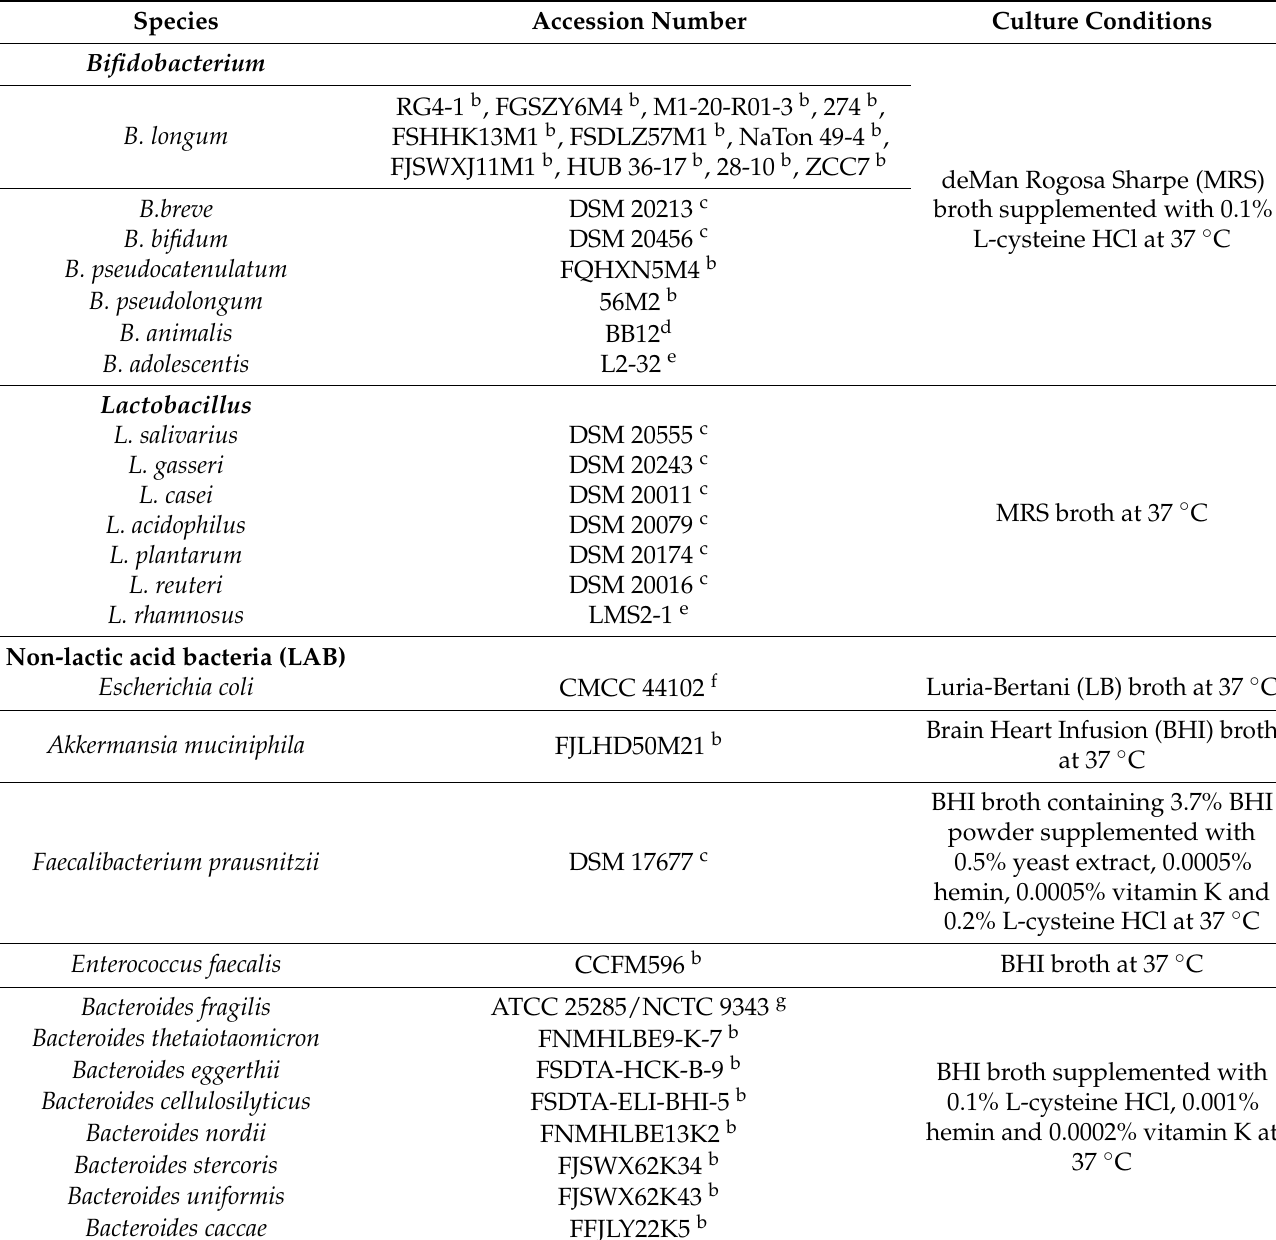
Table 1. Bacterial strains used for primer validation via electrophoresis a